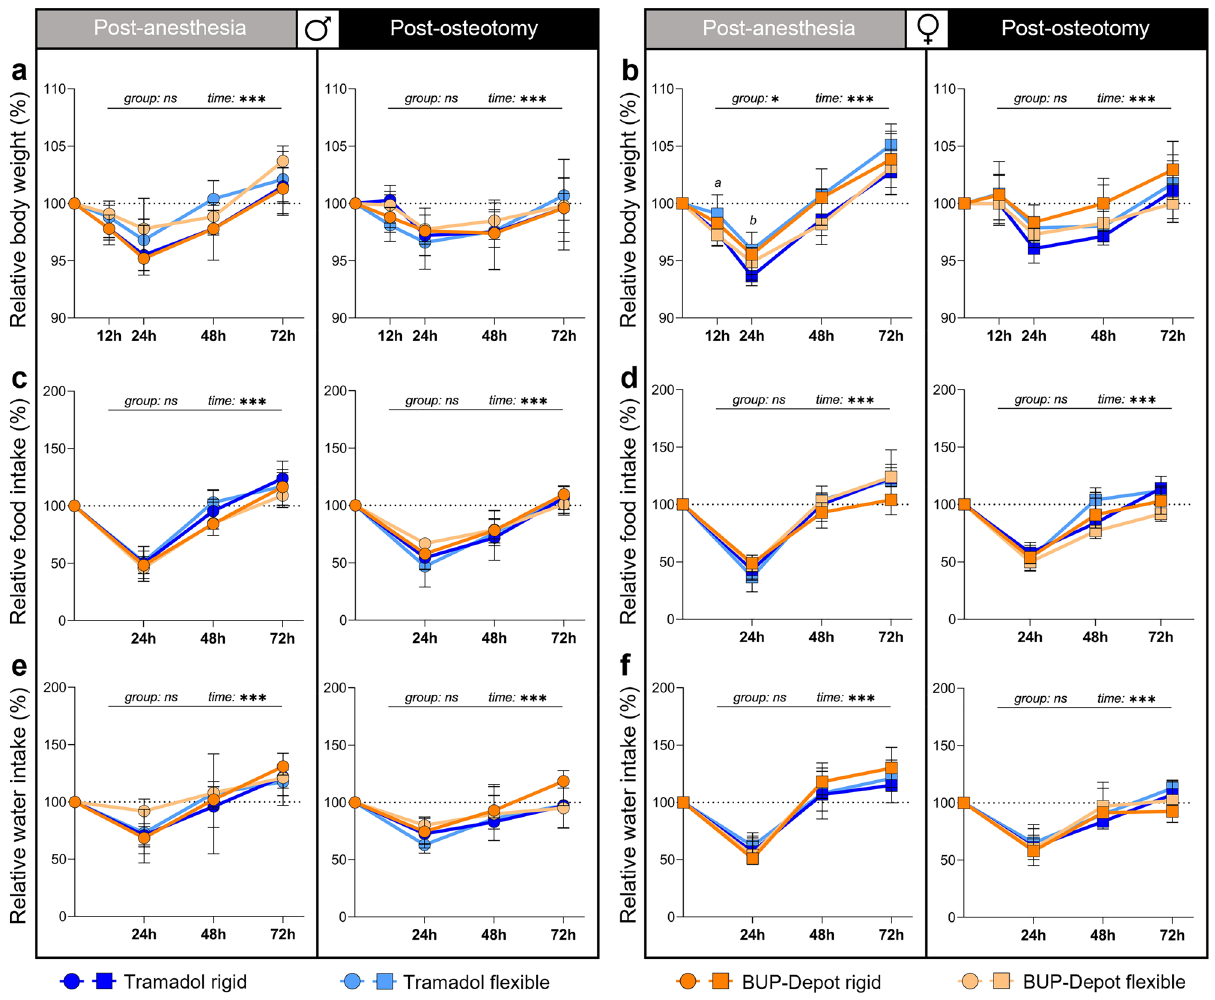
Figure 2. Reduction of body weight as well as food and water intake can be observed at 24 h and 48 h post- anesthesia and post-osteotomy. ( a,b ) Body weight was measured at 24 h, 48 h and 72 h; ( c–f ) and food/water intake was measured at 12 h, 24 h, 48 h and 72 h post-anesthesia and post-osteotomy. Body weight and food/ water intake were normalized to the initial value (0 h = 100%). Of note, mice did not undergo osteotomy during the first intervention (= post-anesthesia). However, they were already assigned to their respective groups post- osteotomy. All graphs show median with interquartile range for n = 9–10 (body weight) and n = 4–5 (food/water intake). Non-parametric ANOVA-type test—main effects of time and of group are represented in the graphs; exact p -values are listed in Table S1–S3; * p < 0.05, *** p < 0.001. To determine group differences Kruskal–Wallis test and Dunn’s post hoc test with Bonferroni correction were performed. ( a ) Significant difference Tramadol flexible vs. BUP-Depot flexible; ( b ) significant difference Tramadol rigid vs. Tramadol Delta composite pain score indicates limited analgesic capacity of Tramadol in male mice with flexible fixation. The composite pain score combines parameters of facial expression (mouse grimace scale) and overall appearance and was assessed at 24 h, 48 h and 72 h post-anesthesia and post-osteotomy. Since we observed an influence of the anesthesia and analgesic regime alone on the composite score (Fig. S4; Table S4– S4.3), we corrected the individual scores post-osteotomy for the respective scores post-anesthesia to obtain a delta composite pain score, that depicts the isolated effect of the osteotomy without the interfering effects of anesthesia and analgesia. The delta composite pain score was highest in all groups at 12 h and 24 h after oste- otomy, and declined after 48 h and 72 h, reaching lowest scores in all groups after 72 h (significant main time effect in both sexes, p < 0.001; Fig. 4a; Table S5). Female mice showed comparable score developments between treatment and fixation groups with the highest median scores (1–1.5) at 12 h. In male mice, we found a signifi- cantly higher delta composite pain score in the flexible fixation group treated with Tramadol at 24 h (median score = 2) and 48 h (median score = 1.5) (Kruskal–Wallis test of all groups at 24 h: p = 0.031 and at 48 h: p < 0.001; Table S5.1) when compared to the other groups (Dunn’s post hoc test for Tramadol flexible vs. BUP-Depot flex- ible, BUP-Depot rigid and Tramadol rigid, respectively: 24 h p = 0.077, 0.042, 0.032; 48 h p = 0.004, < 0.001, 0.018; Fig. 4a; Table S5.2–S5.3).